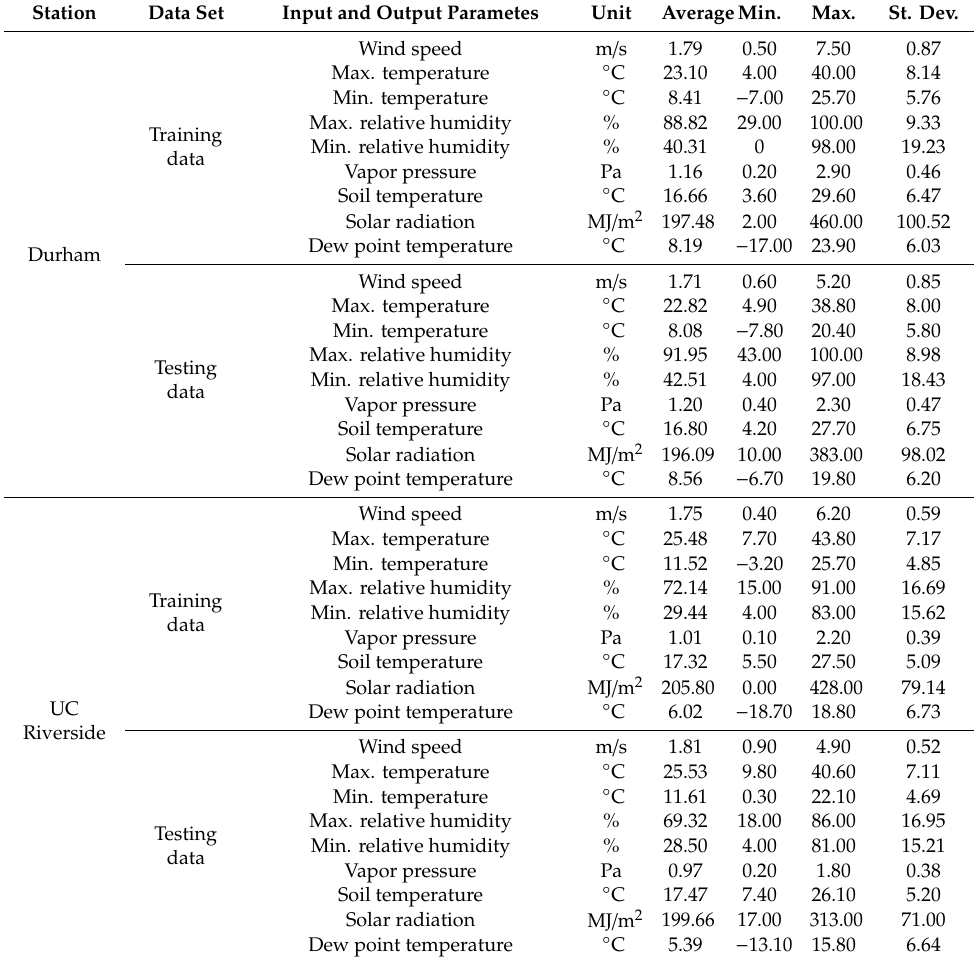
Figure 2. The locations of the Durham and UC Riverside stations in the state of California, USA. Table 1. Basic statistical properties of the used dataset.